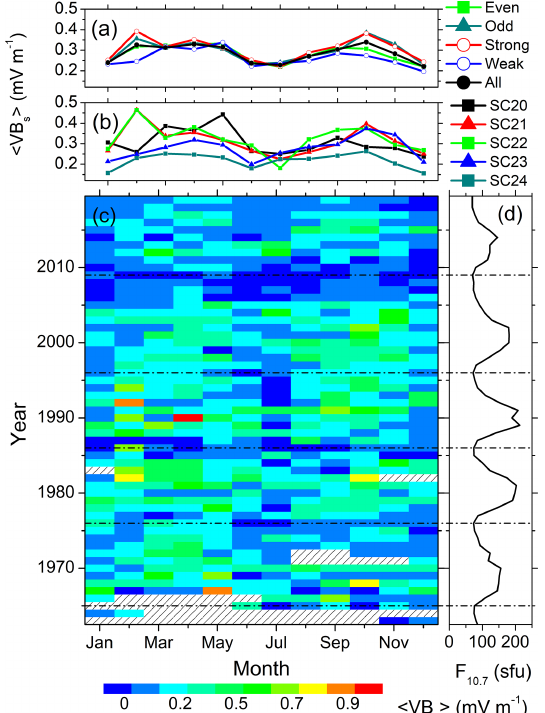
Figure 11. Solar wind coupling function VB s variation from 1963 to 2019. The panels are in the same format as in Fig.